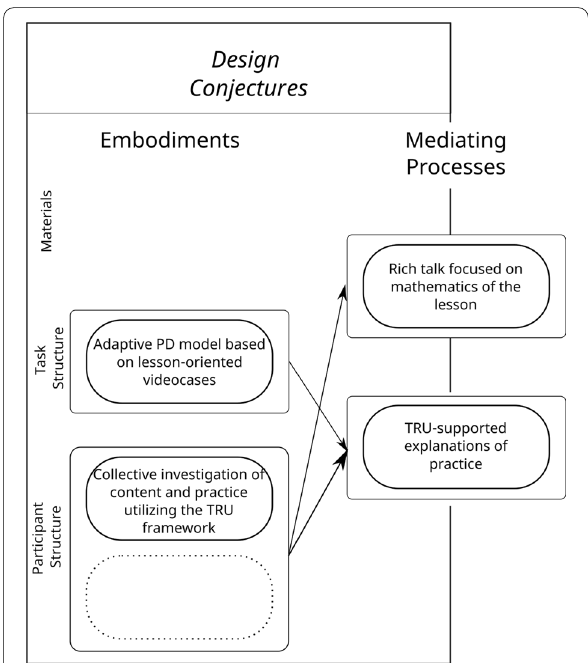
Fig. 4 Elements of the conjecture map that show up in the second activity structure. The dashed lines indicate an element coding recommended to